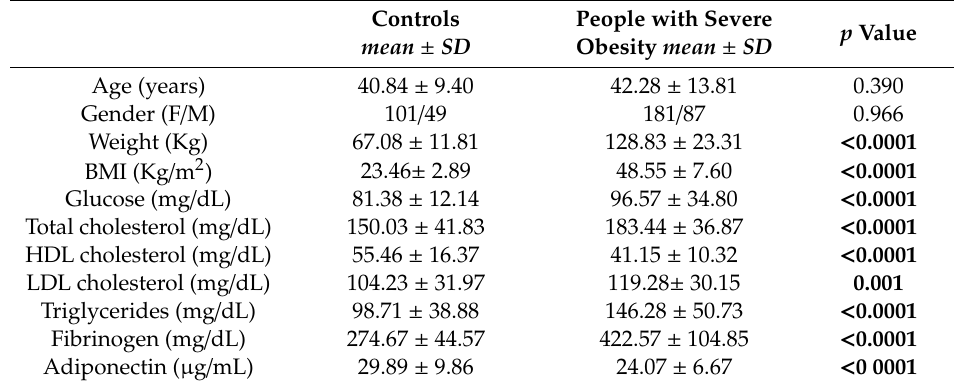
Table 1. General and biochemical parameters of the control group and the people with severe obesity at